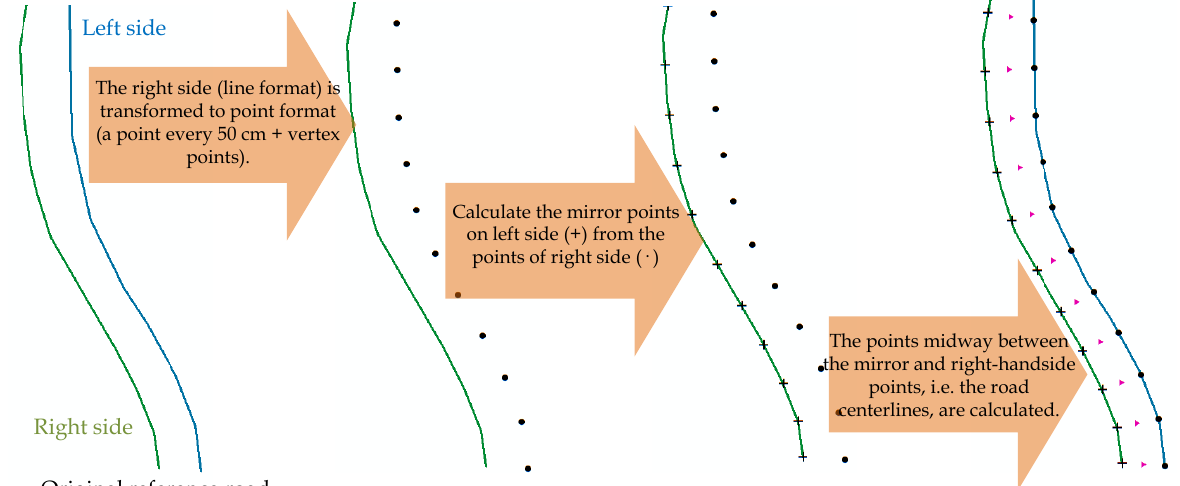
Figure 3. Flowchart of the automatic method used to calculate the road centerlines from the